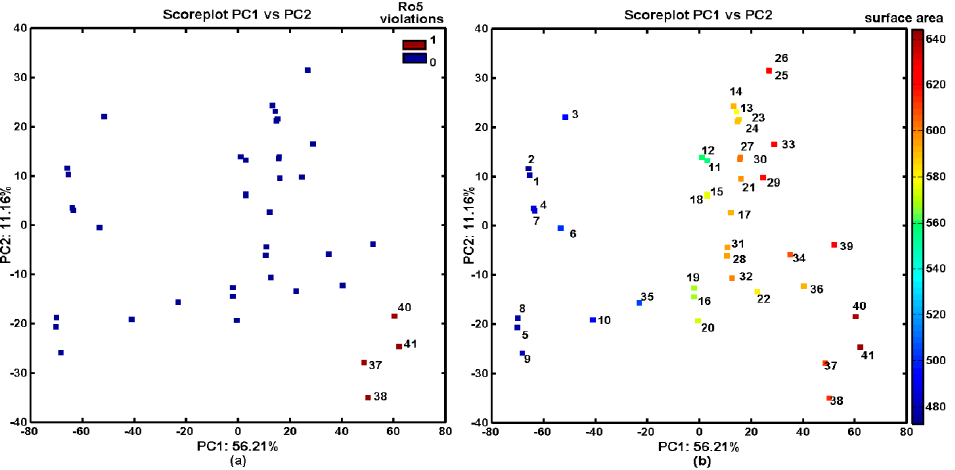
Figure 4. Projection of carbamates 1 – 41 on the plane defined by the first vs. second principal components with: Ro5 rule violations ( a ); and the calculated surface area ( b ). Colors indicate the number of Ro5 violations and the numerical values of surface area.